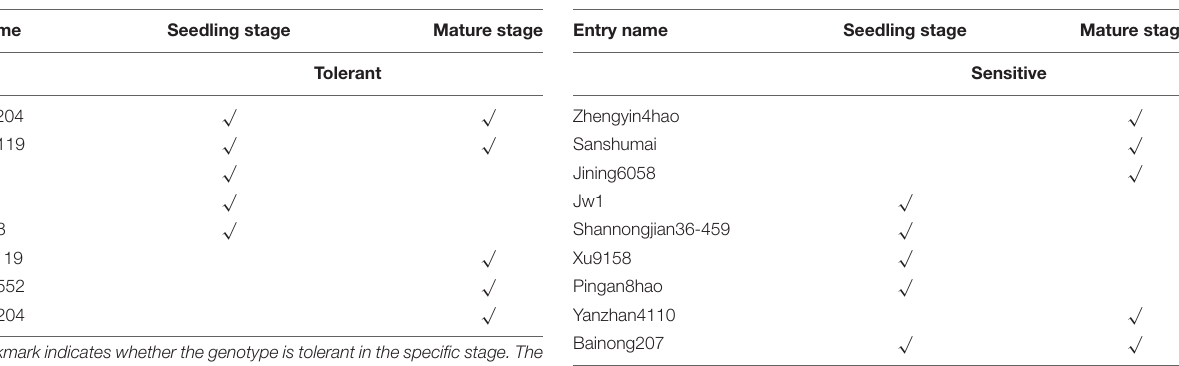
TABLE 4 | Low-K sensitive genotypes identified based on the D values in more than one growth